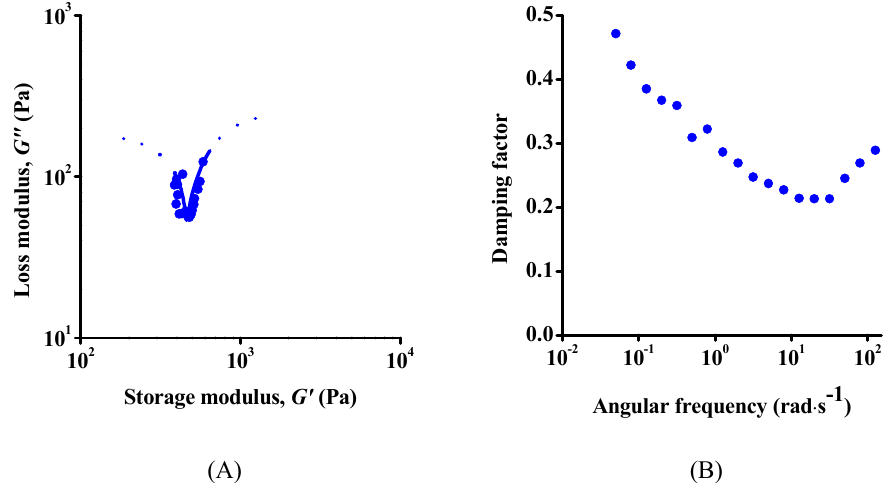
Figure 6. Cole–Cole representation ( A ) and the frequency dependence of damping factor ( B ) of fresh suspension.